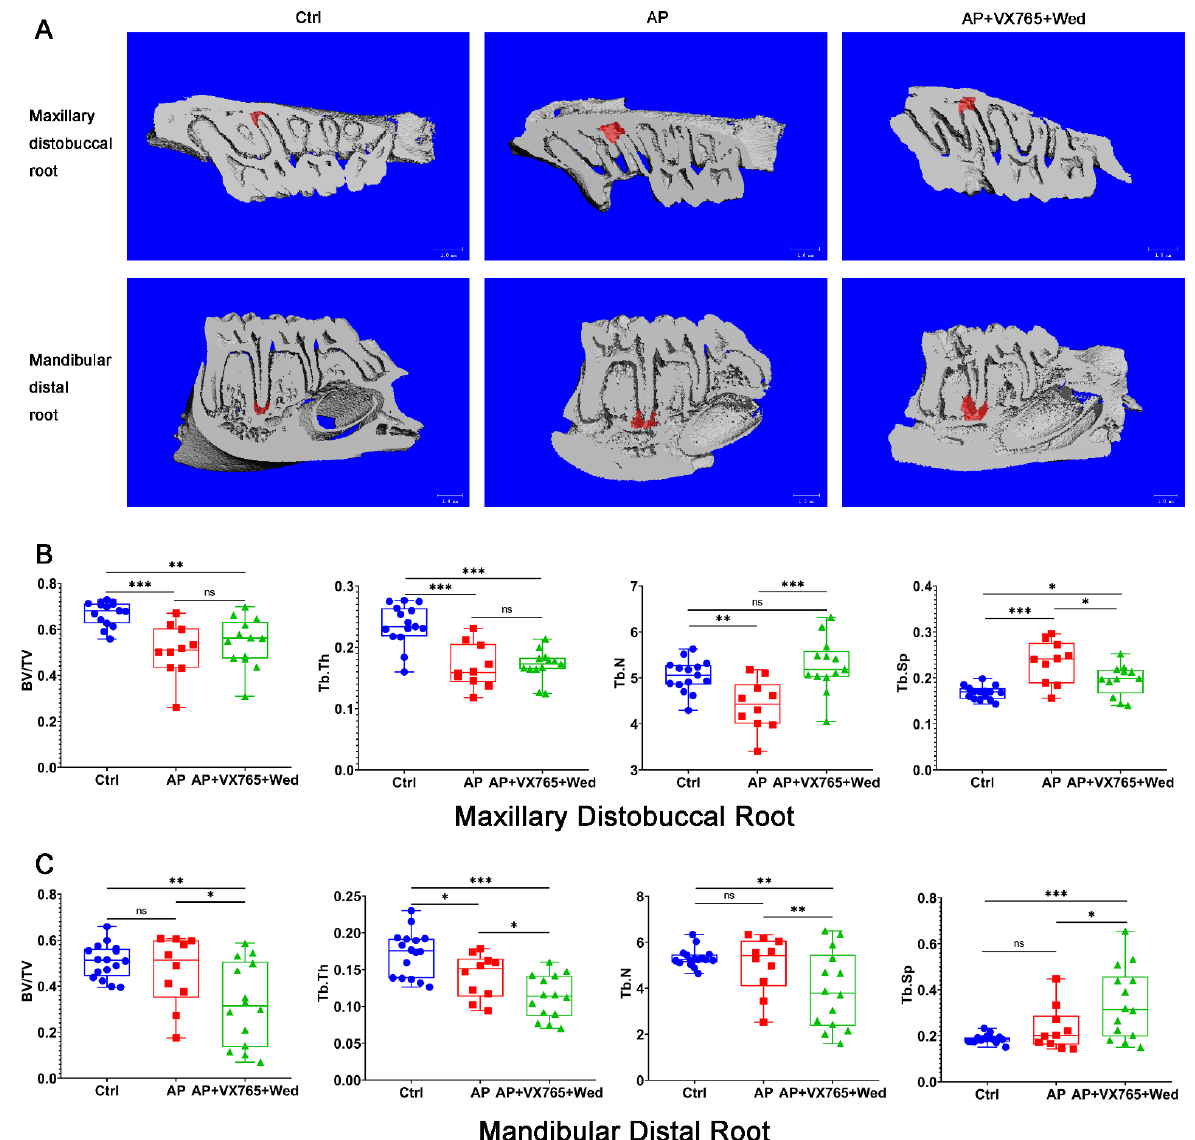
Figure 5. Inhibition of caspase-1 and -11 decreased bone loss when AP was larger (maxilla). In contrast, bone loss was increased when AP was smaller (mandible). ( A ) Three-dimensional re- construction of EAP. ( B , C ) Bone loss of the maxillary distobuccal root and mandibular distal root (one-way ANOVA, n = 10~16; *, p < 0.05; **, p < 0.01; ***, p < 0.001; ns, no